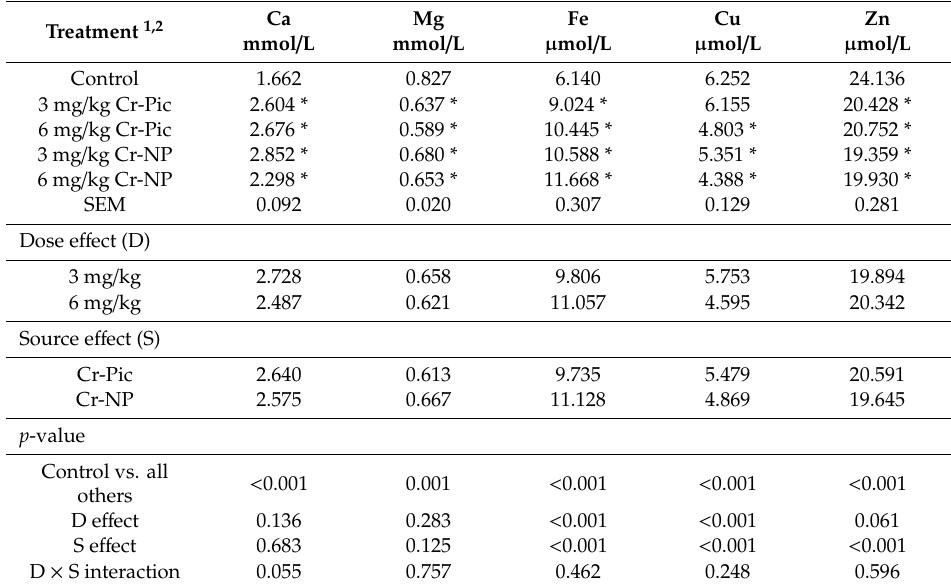
Table 3. Content of minerals in the blood plasma of